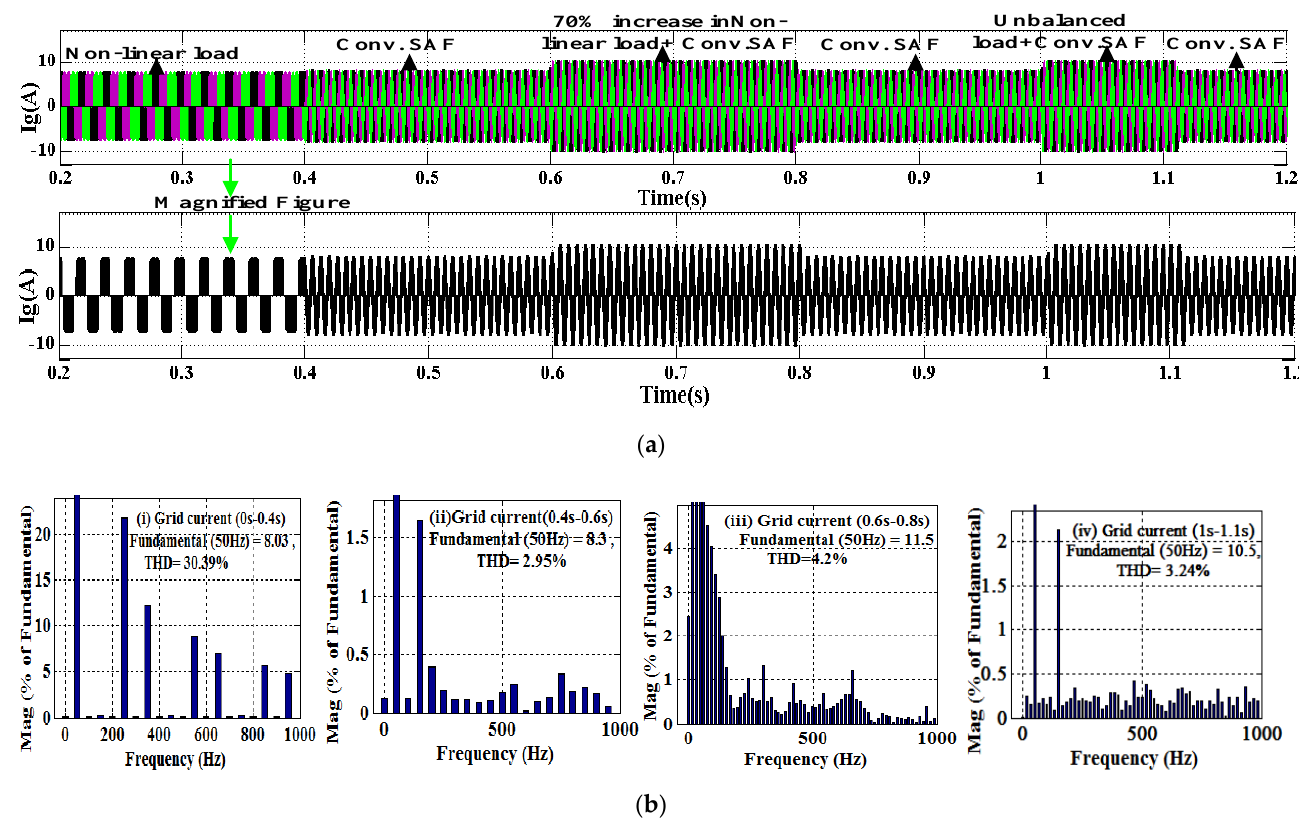
Figure 9. ( a ) Traditional grid current results ( b ) Traditional FFT results.